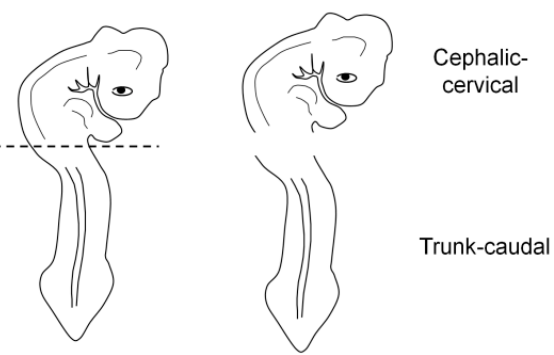
Figure 3. Embryo fragmentation into cephalic-cervical and trunk-caudal portions.